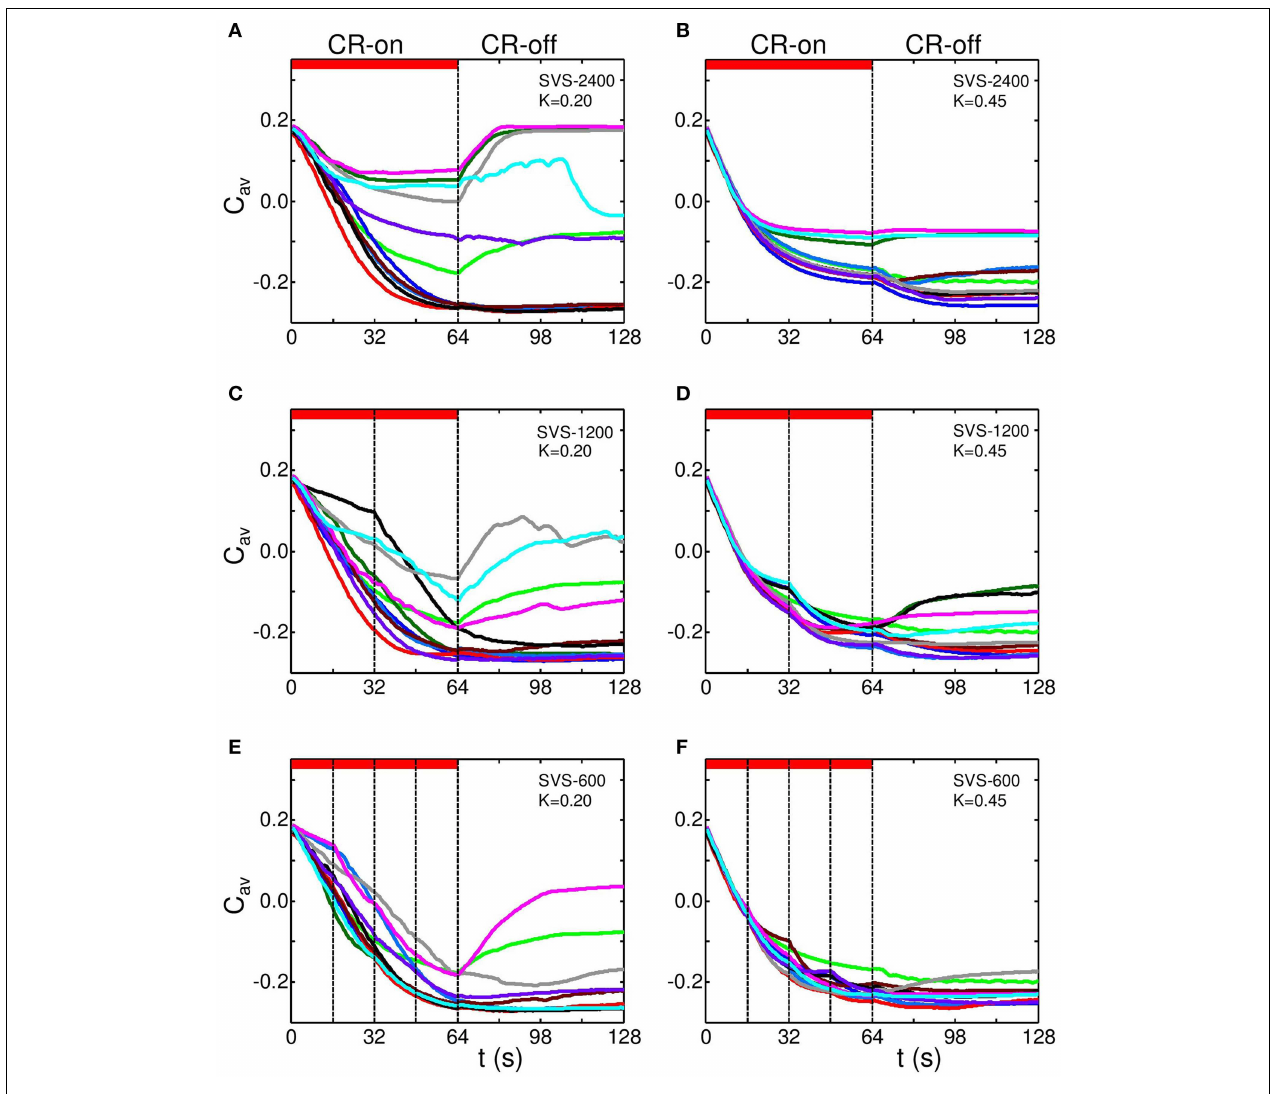
FIGURE 6 | Effect of switching the sequence during CR stimulation. In a series of simulations with different stimulation intensities ( K = 0 .20 in left panels and K = 0 .45 in right panels) the sequence was either kept fixed [FS CR stimulation, (A,B) ], randomly varied just once [in the middle of the stimulation period, at t = 32 s, (C,D) ] or randomly varied at three equidistant times [at t = 16 , 32, 48s, (E,F) ]. Simulations were performed for eleven different sequence orders and initial network conditions. Each panel shows the dynamics of C av for each of the eleven simulations in a different color. FS CR stimulation (A,B) : Time course of C av for eleven combinations of different initial network conditions and different sequence for